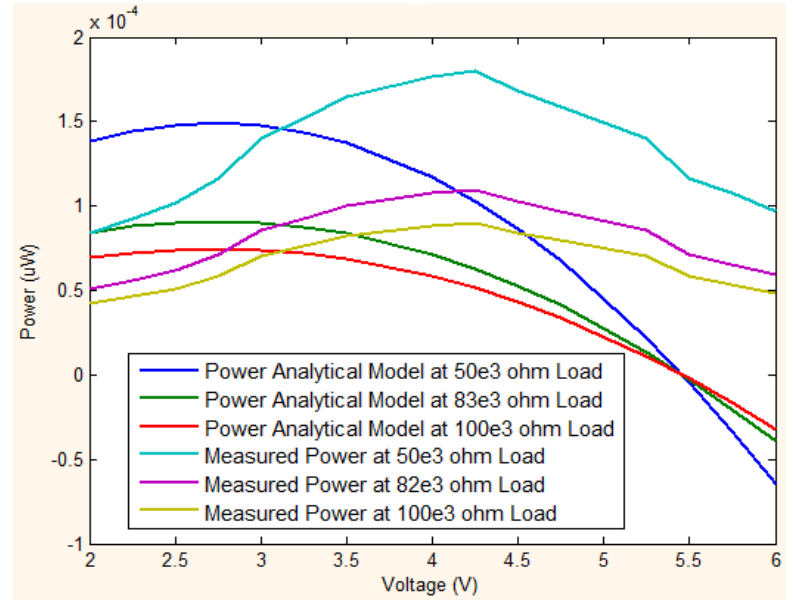
Figure 10. Analytical model and measured power for the TEG ‐ EH source with different loads.